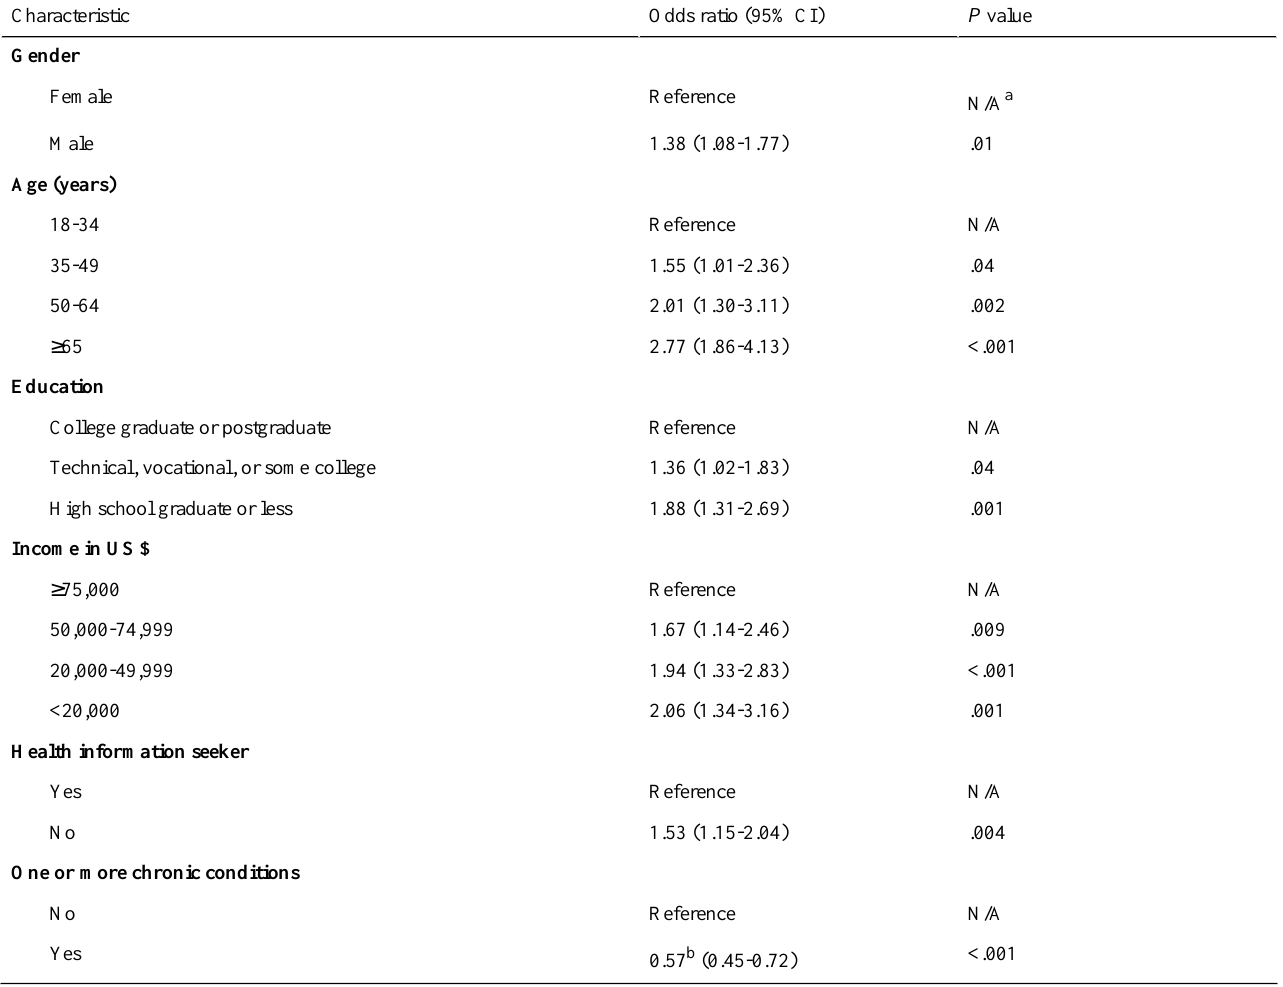
Table 2. Sociodemographic and health-related characteristics significantly associated with being in the mobile health nonowners and nonusers category (n=1468). Reference category=all mobile health owners and